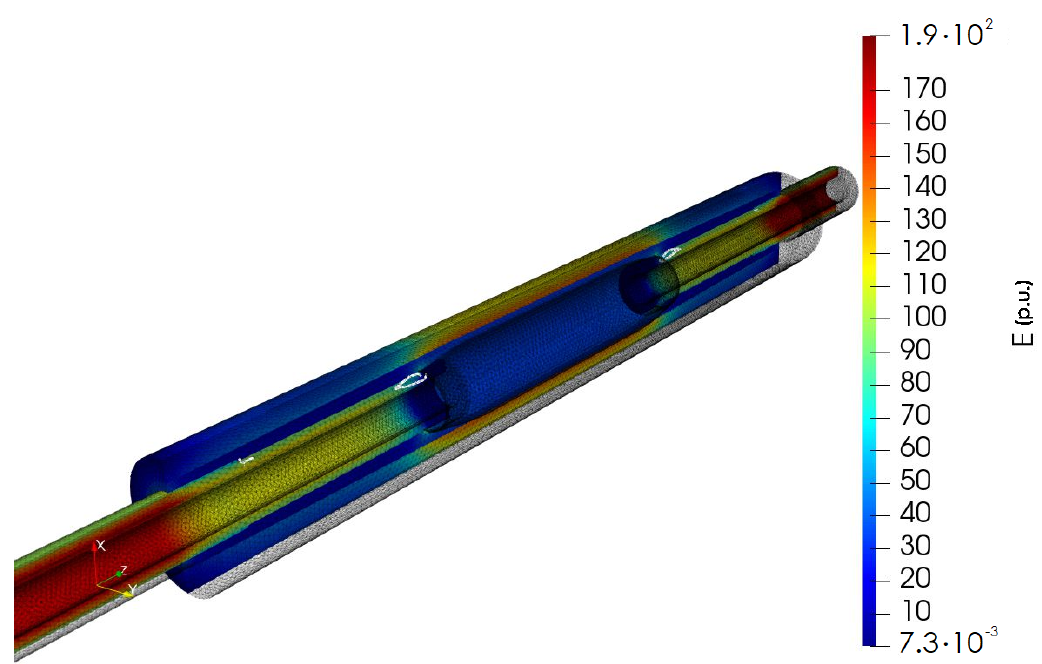
Figure 14. Voltage measured by the electrodes during rge.